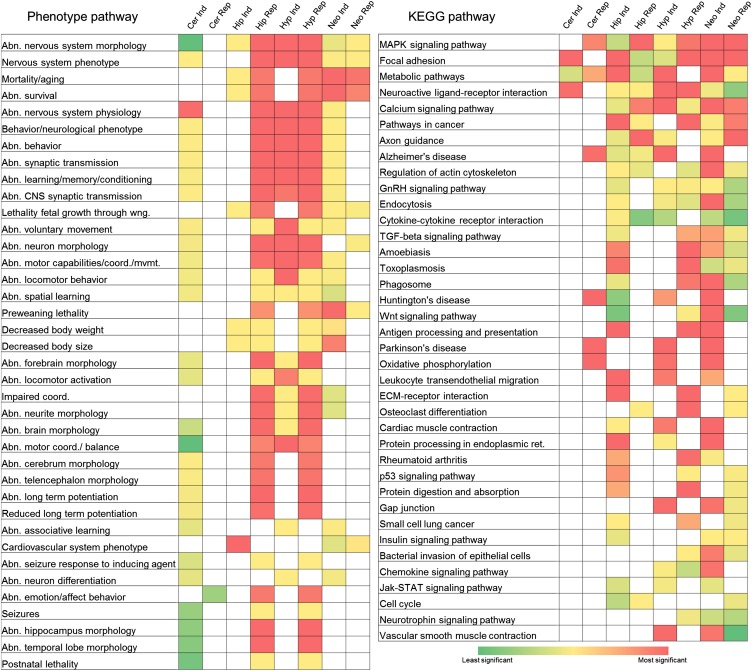
Phenotype ontology and KEGG ontology enrichments. The differentially expressed genes were separated into genes that were either induced (Ind) or repressed (Rep) with respect to virgins and analyzed for significantly enriched phenotype pathways and KEGG (Kyoto Encyclopedia of Genes and Genomes) pathways. The brain region abbreviations are: cerebellum (Cer), hippocampus (Hip), hypothalamus (Hyp), and neocortex (Neo).